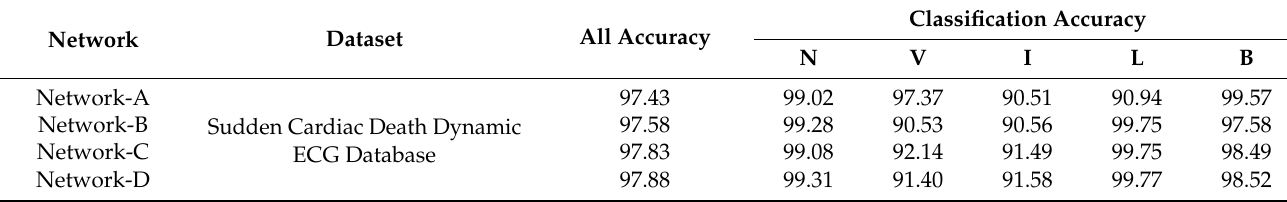
Table 6. Test results of all networks on type IV